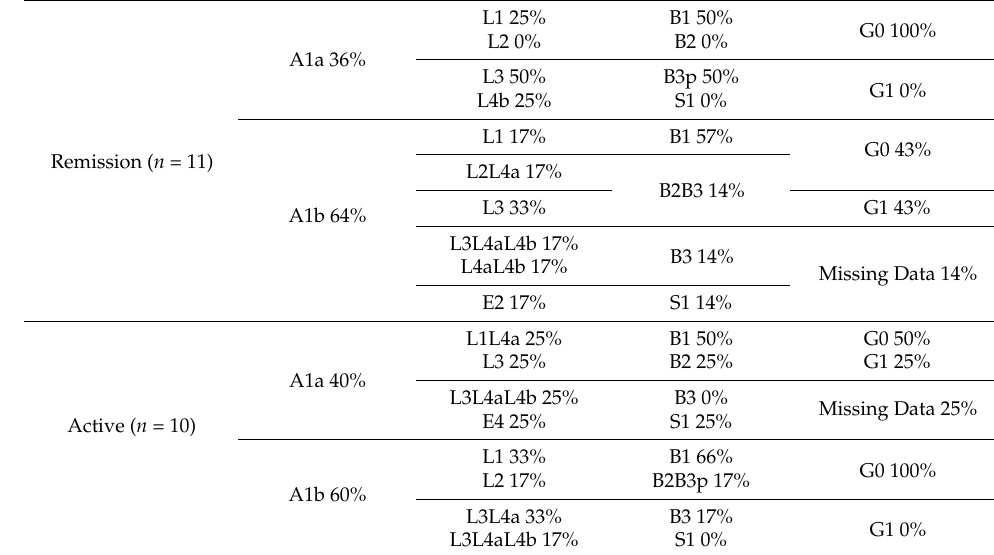
Table 1. Paris Classification. Age at diagnosis: A1a (0–<10 years); A1b (10–<17 years).